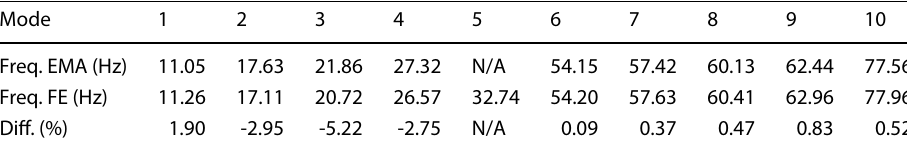
Table 2 Natural frequencies of the first 10 modes of vibration, EMA vs FE modal